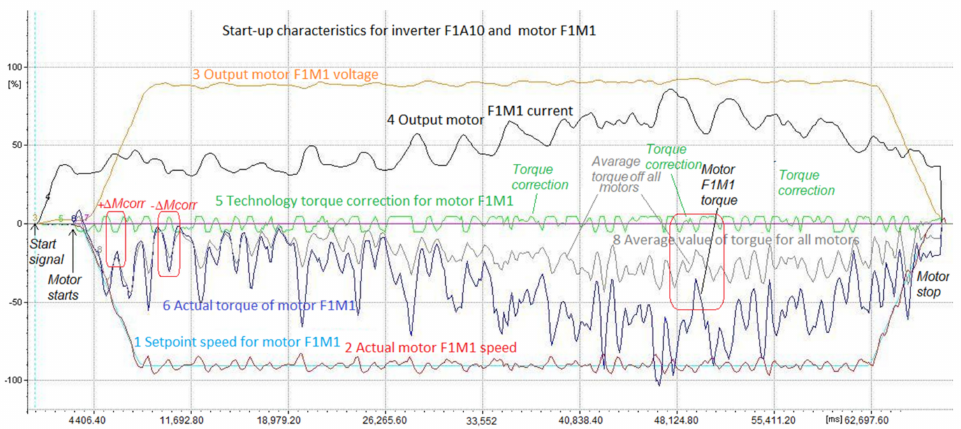
Figure 8. Starting curves of the F1M1 stacker motor with torque